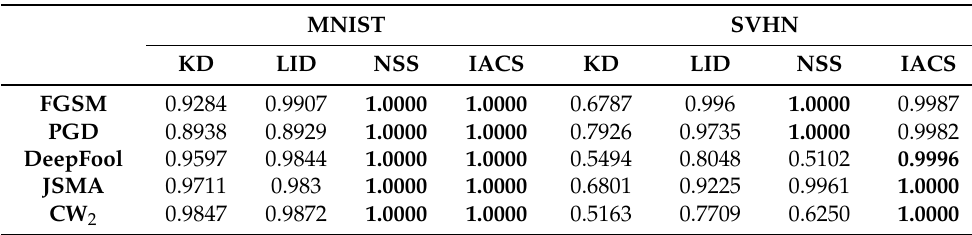
Table 2. The AUC score of different detection methods including the KD-based method, the LID- based method, the NSS-based method, and the IACS-based (our method) method on MNIST and SVHN datasets. The best results are highlighted in bold.